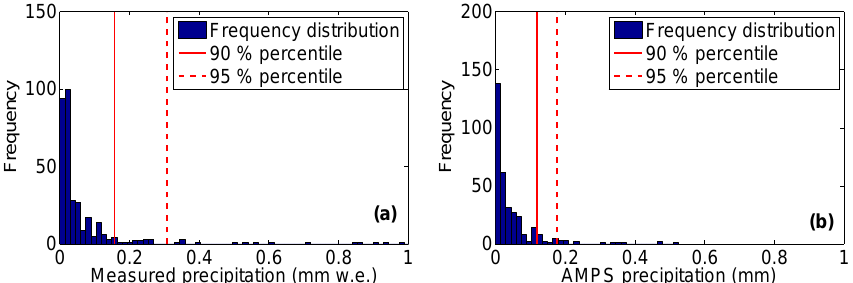
Figure 3. (a) Histogram of the precipitation measurements in mmw.e. with a distance of 0.015mmw . e . between the bins; the two highest values (1.4 and 2.1mmw.e) are not shown. (b) Histogram of the precipitation simulations from AMPS with the same distance of 0.015mm between the